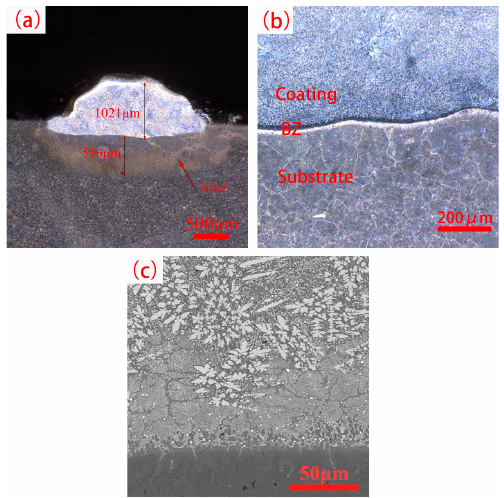
Figure 1. The cladding condition of the coating cross-section. ( a ) coating cross-section; ( b ) the binding zone at low multiples; ( c ) the binding zone at high multiples.